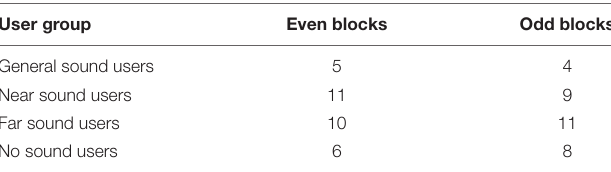
T (9) = − 4.27, p = 0.012/ T (9) = − 4.31, p = 0.012 (unimodal vs.